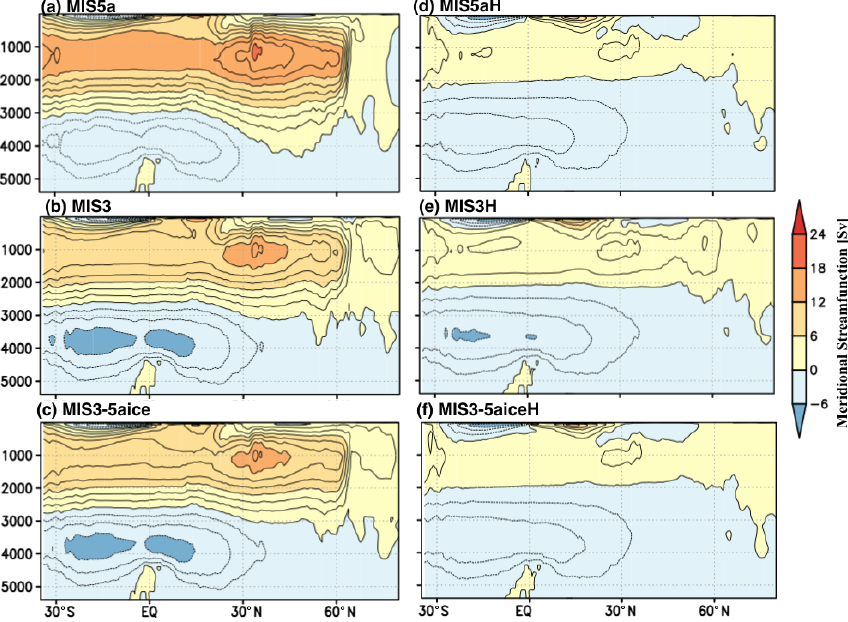
Figure 4. Meridional streamfunction (Sv = 10 6 m 3 s − 1 ) in the Atlantic. (a) MIS5a, (b) MIS3, (c) MIS3–5aice, (d) MIS5aH, (e) MIS3H, and (f) MIS3–5aiceH. The last 100 years are used for analysis.